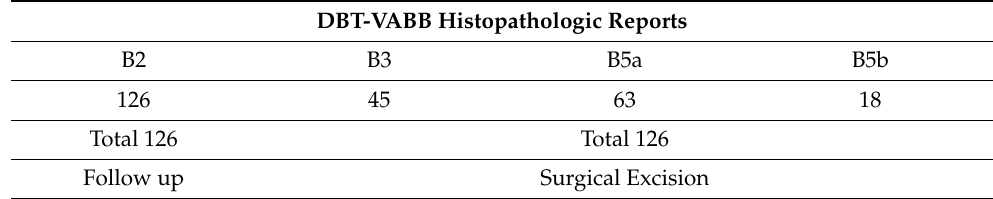
Table 1. The table shows how the patients were divided into two groups: one addressed to follow up and the other addressed to surgical excision, based on the histopathological category of the biopsy sample; DBT-VABB: digital breast tomosynthesis-guided vacuum-assisted breast biopsy.